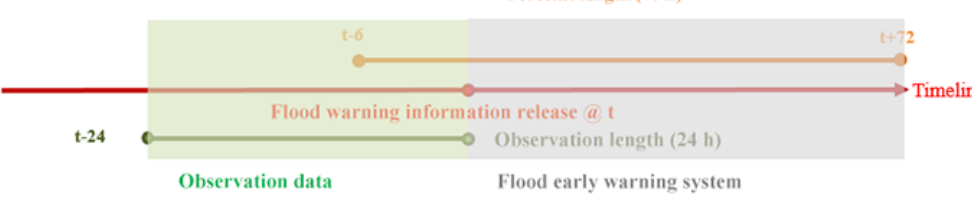
Figure 4. A combination of real-time rainfall observations and forecasts to improve 1 to 24h inundation forecasts.